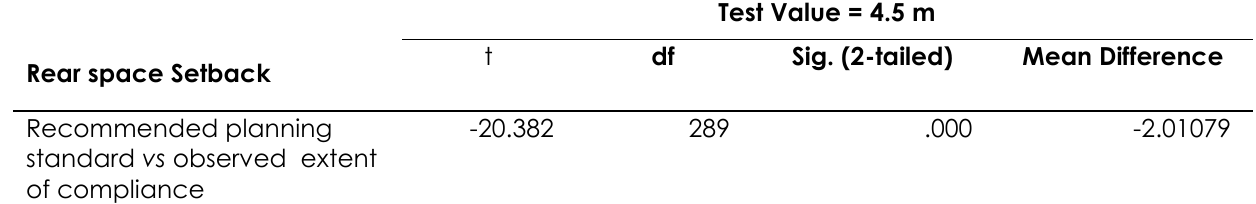
Table 8: Significance test for the third